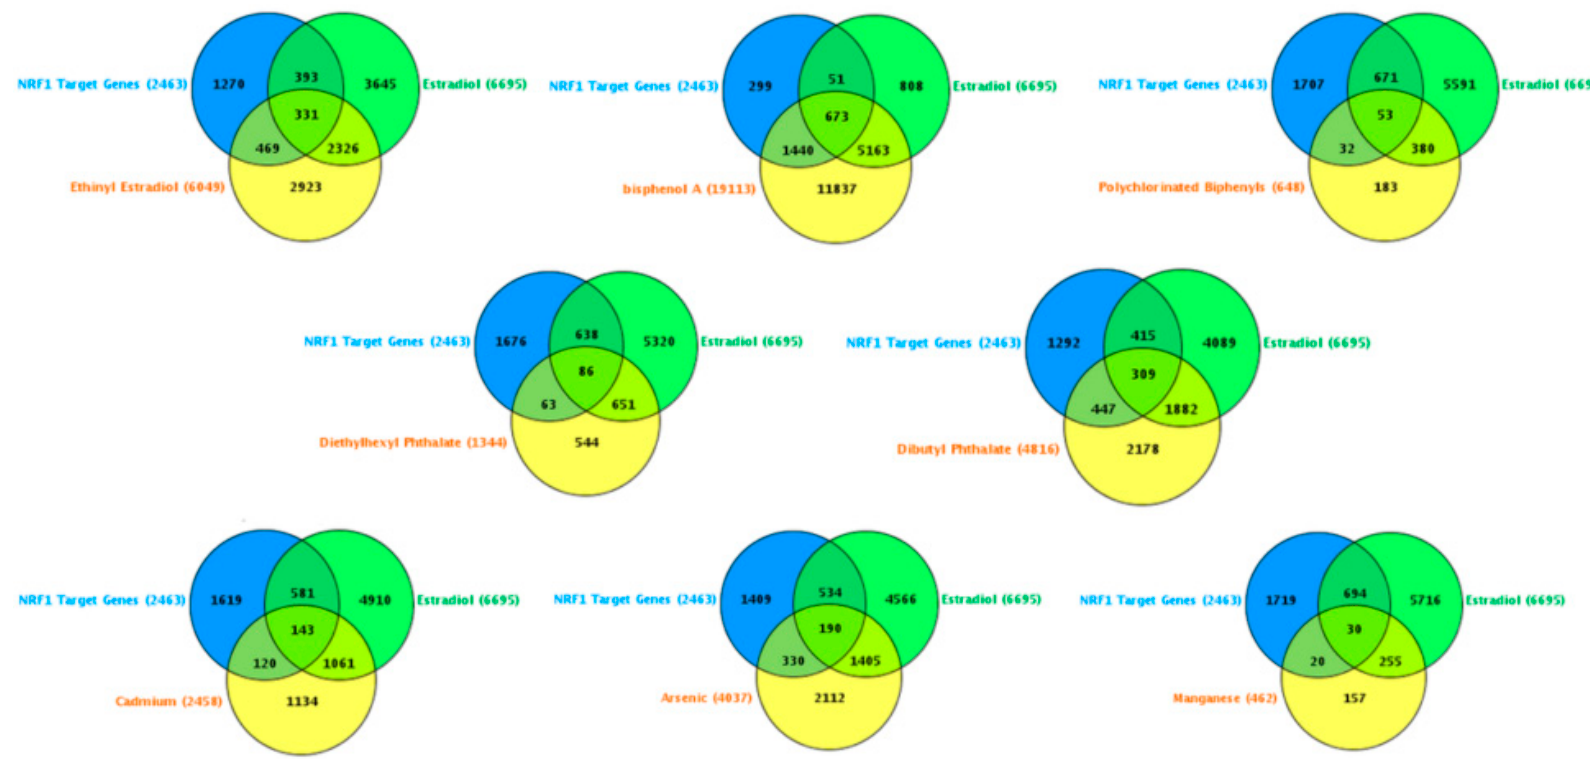
Figure 3. A Venn diagram showing the individual pharmacological estrogen or estrogenic Endocrine Disruptor (EED) modified genes common to both NRF1 and/or estrogen signaling pathways. NRF1 target genes were mapped between 17- β estradiol (E2) and pharmacological estrogen-ethinyl estradiol or PCBs or BPA or phthalates or Cd or As or Mn.